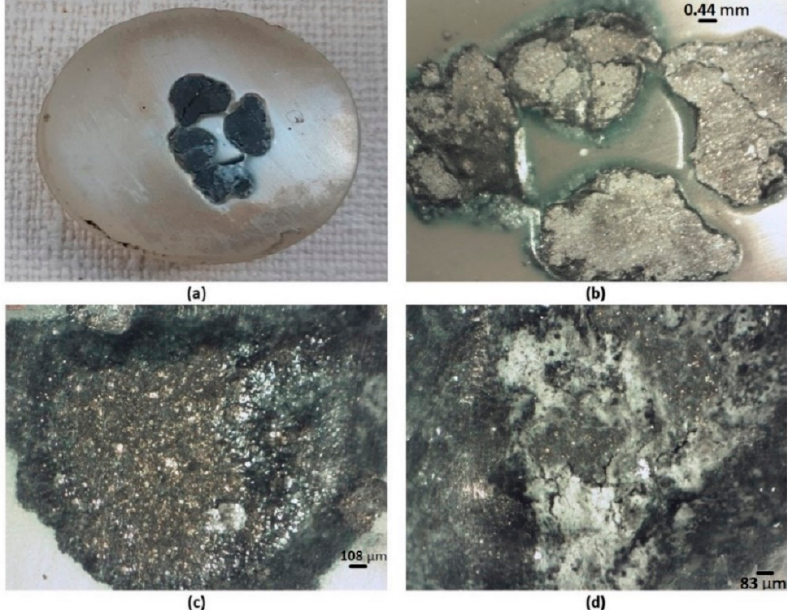
Figure 5. Images of the agglomerates obtained with a stereographic microscope. In ( a ) initial briquette, ( b ) at a magnification of × 0.75 and ( c , d ) at × 5.